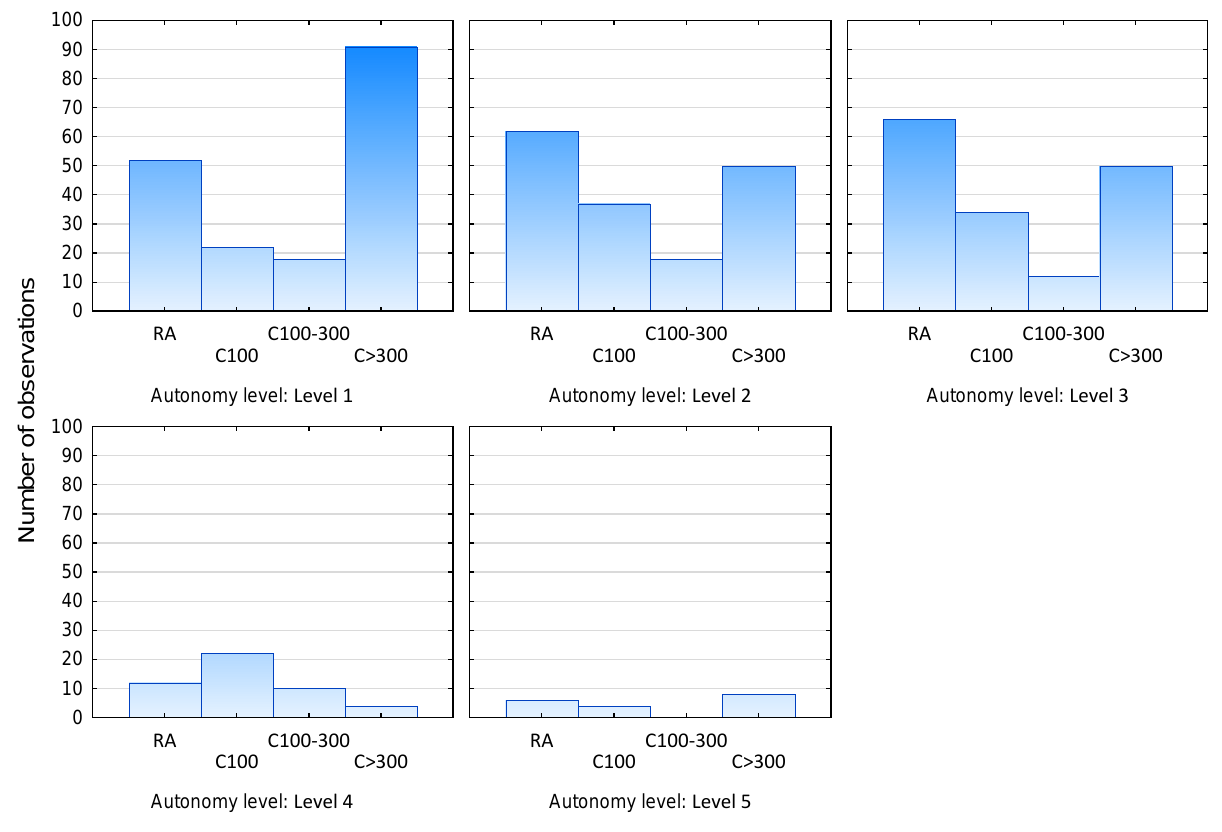
Figure 6. Categorized data histogram showing respondents’ opinions by place of residence in relation to the level of autonomy.